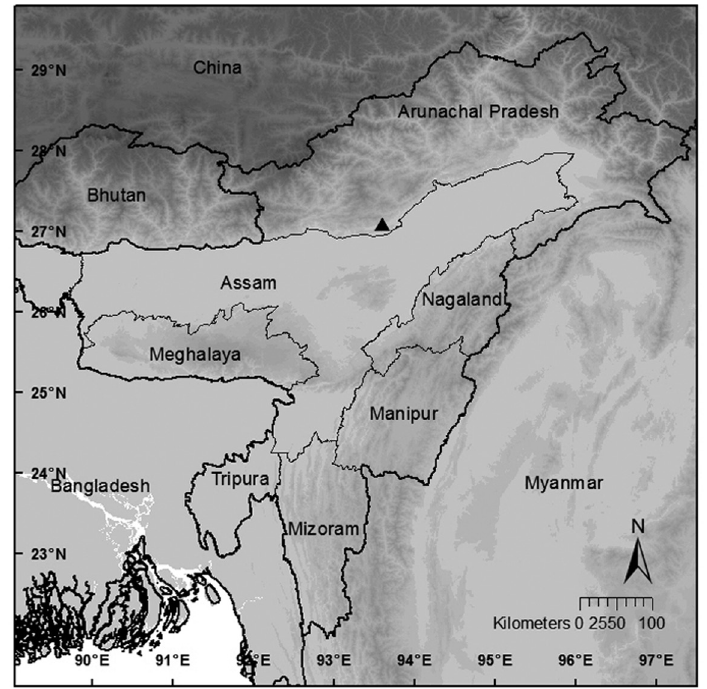
Fig. 56. Map showing the location of B. shilendrae Rekha Morris & P.D.McMillan